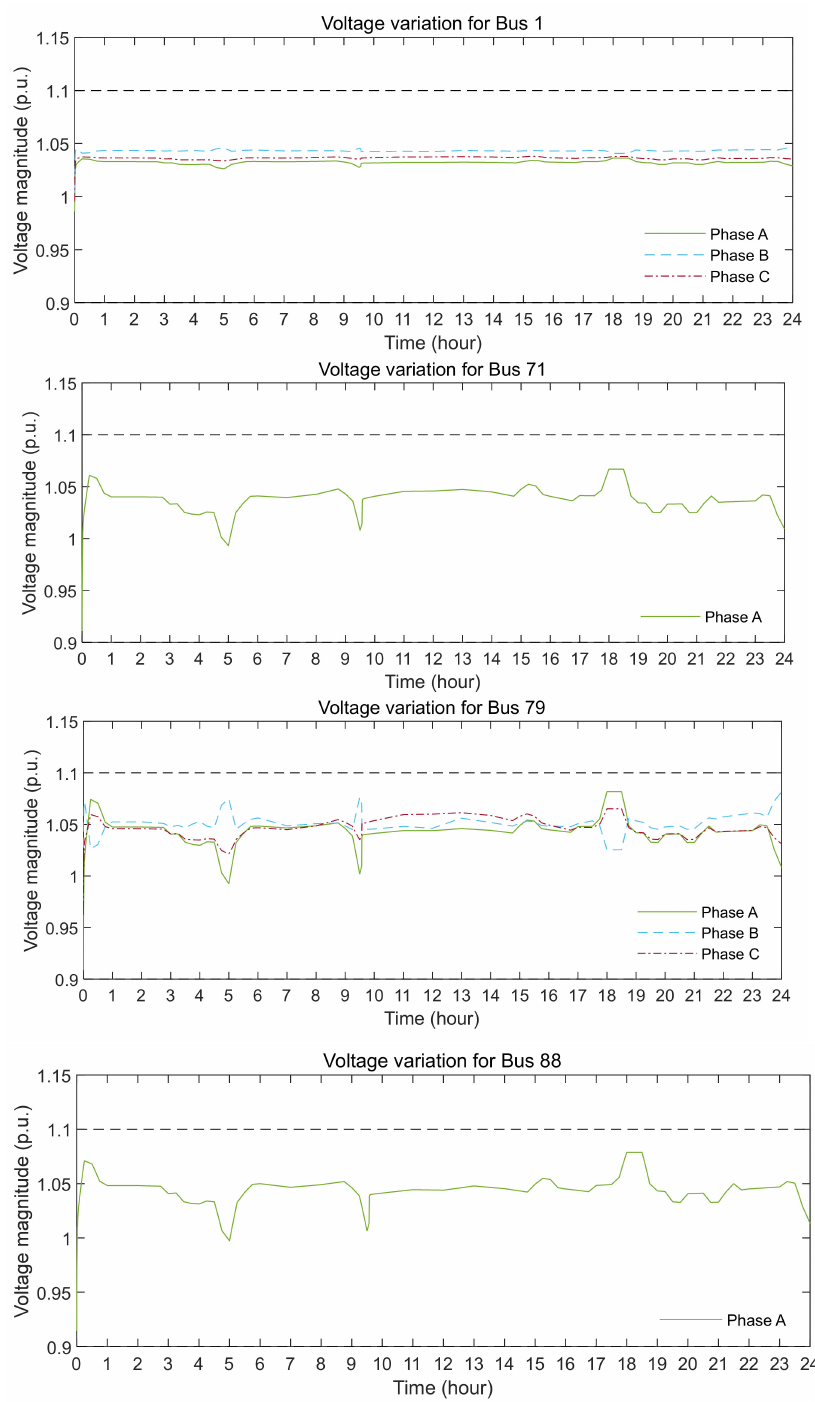
Figure 15. Entire day voltage variations at Buses 1, 71, 79, and 88 for load type